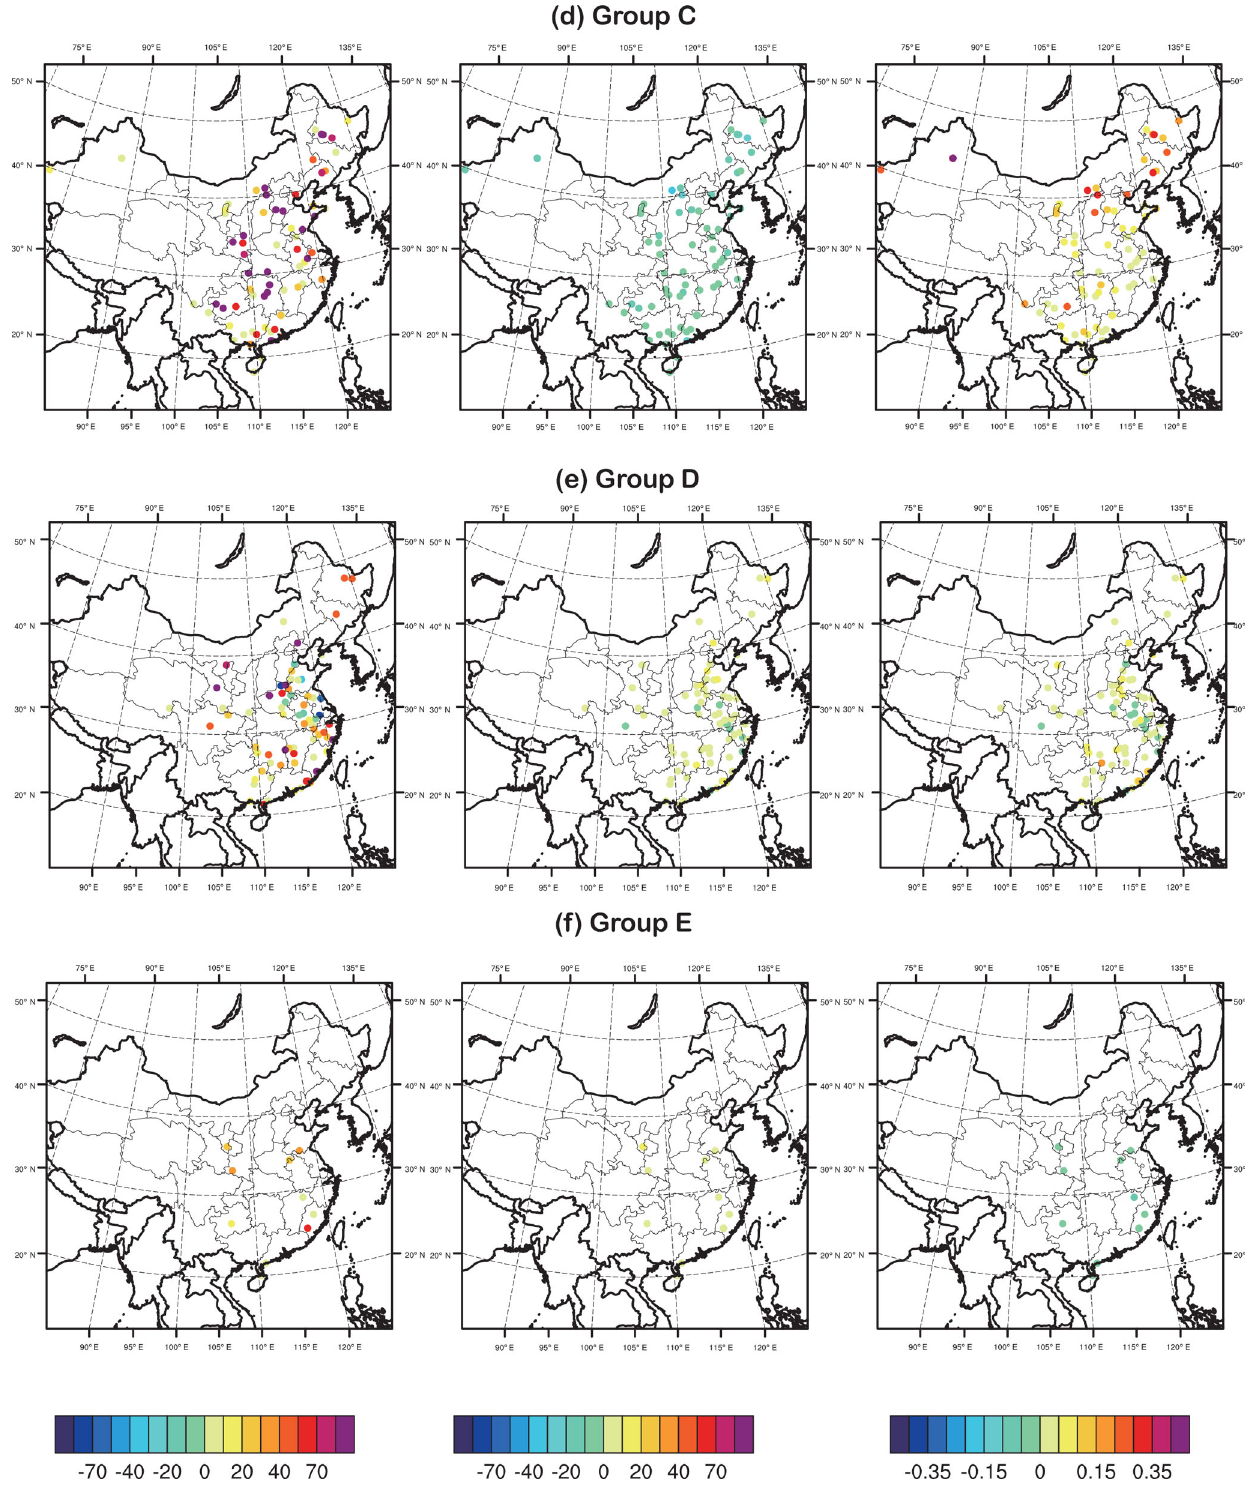
Figure 12. Same as Fig. 11, but for January